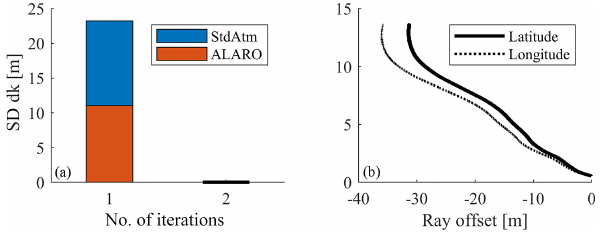
Figure 3. Convergence behavior (a) and ray-traced signal path dif- ferences after convergence (b) . All iterations are based on the same first guess (standard atmosphere or ALARO numerical weather model data) but differ with respect to the refractivity field used for reconstruction of the bended signal